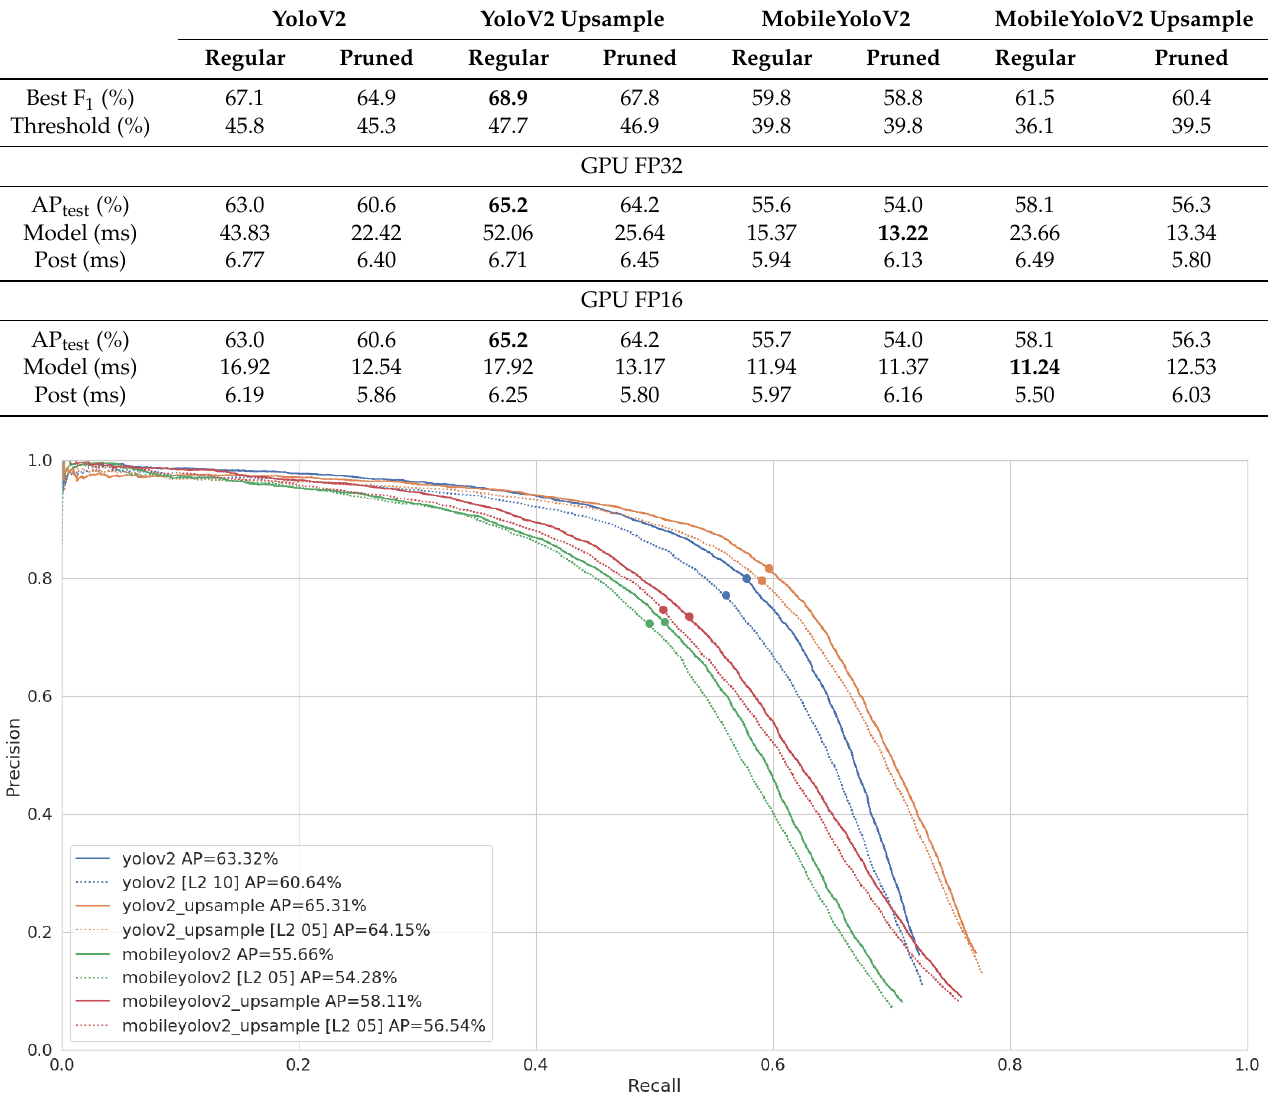
Figure 10. Micro-averaged Precision-Recall (PR) curve and AP of our models on the Pascal VOC test set. The best F1 point is marked for each curve, which is used as a confidence threshold when performing the timing